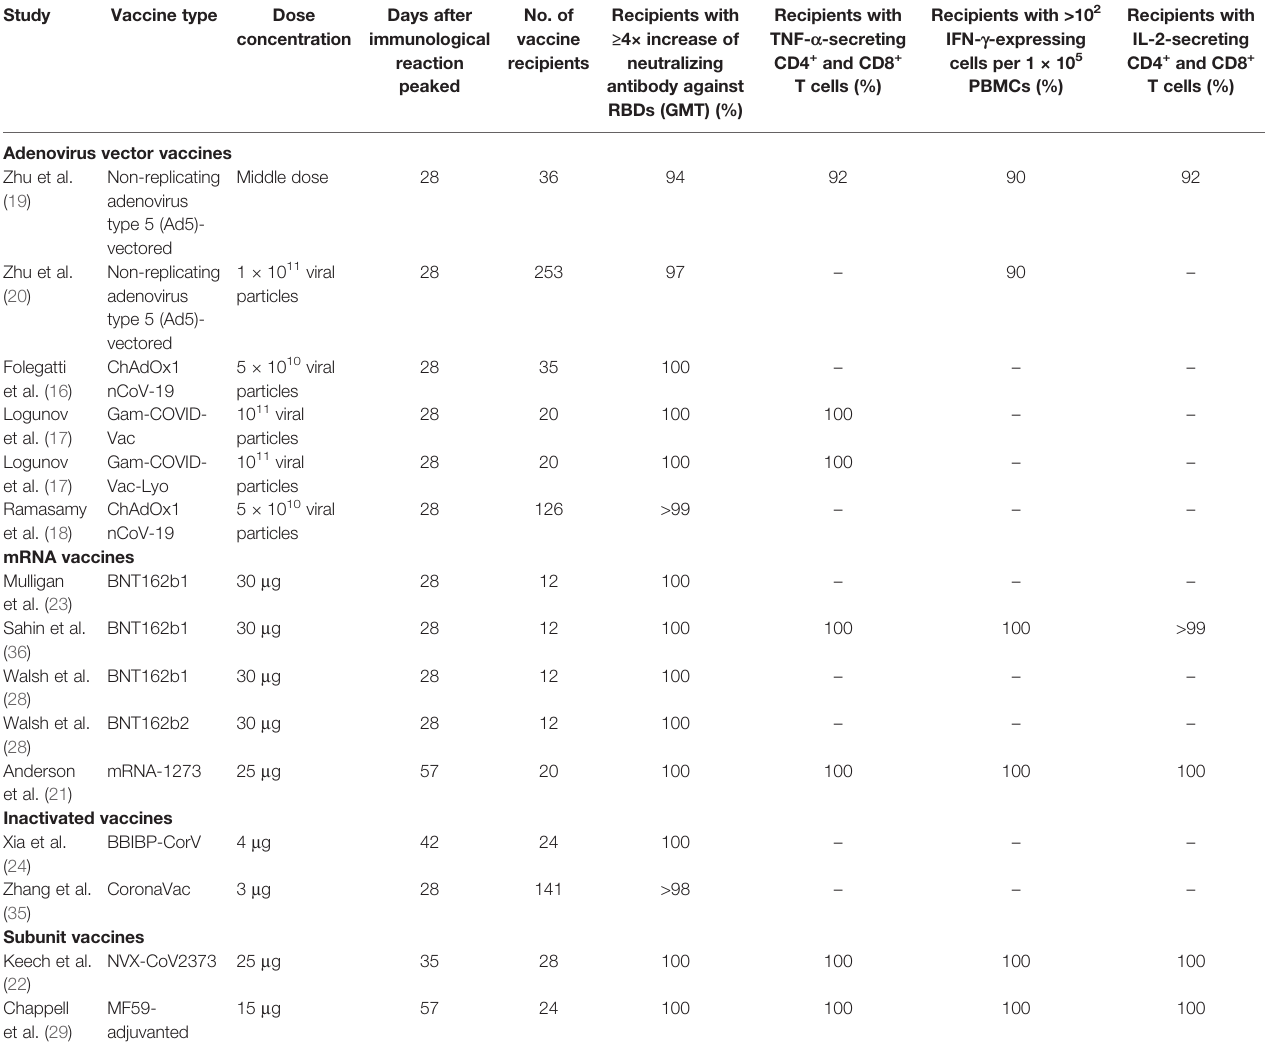
TABLE 3 | Clinical trials on the immunogenicity of COVID-19 vaccines included in this